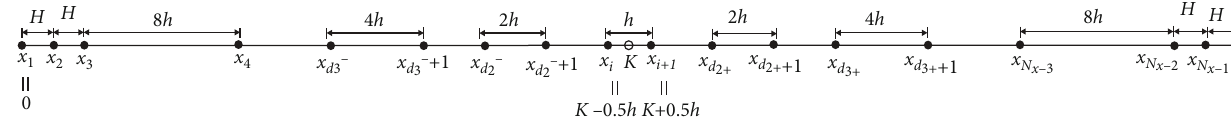
Figure 7: Piecewise-uniform mesh Ω